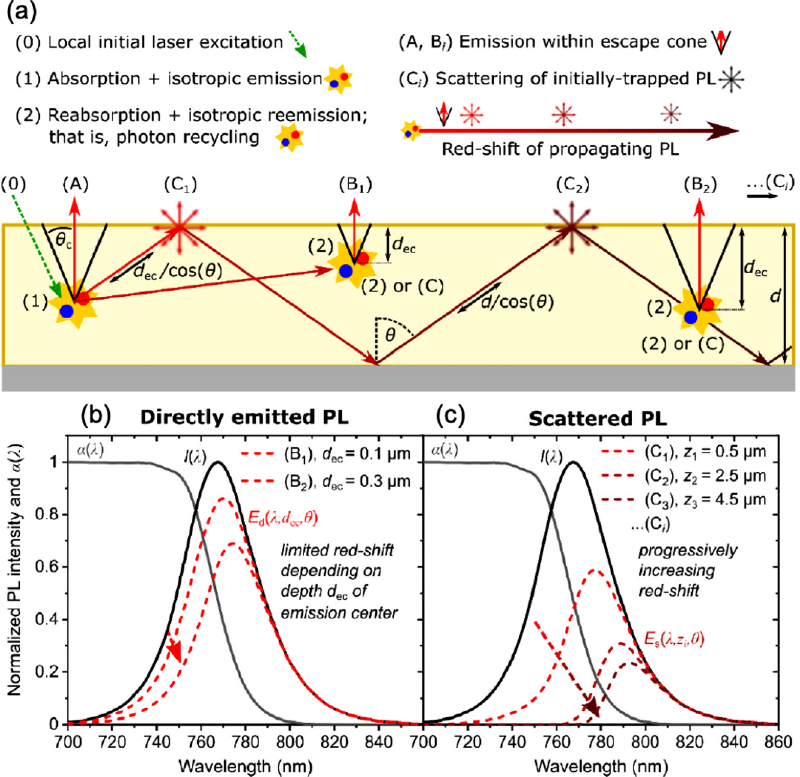
Figure 8: (a) Schematic diagram showing the photoluminescence (PL) emission process from perovskite films. (A) Representation of the various radiative mechanisms (numbers) and PL emission paths (letters) in a perovskite film: (0) Initial source (laser) excitation; (1) isotropic internal radiative recombination (emission); (A) PL emitted within the escape cone ( θ < θ c ) and collected for measurement; (2) Reabsorption and re-emission of photons, i.e. photon recycling; ( B i ) and ( C i ) are the PL emitted within the escape cone following (2) and at angles θ > θ c (photons trapped within the perovskite fi lm by total internal re fl ections) and coupled out upon scattering (scattered PL). The change in the photon trajectory color from red to brown represents the increase in red-shift of PL in the perovskite fi lm. In this analysis, it is assumed that thereisaperfectback-re fl ectoratthebottom.(b)DirectlyemittedinternalPLspectrum( λ )(black)andabsorptioncoef fi cient( λ )(gray)showing a small red-shift depends on the depth d ec of the center of the emission within the perovskite fi lm. (c) Redshift is observed in the scattered PL spectrawiththeincreasingnumberoftotalinternalre fl ections( i )withtheentirepropagationdistance z i .TheprogressiveredshiftinPLclearly shows the photon-recycle process in perovskite fi lm. Figure (a) – (c) are taken with permission from Ref.